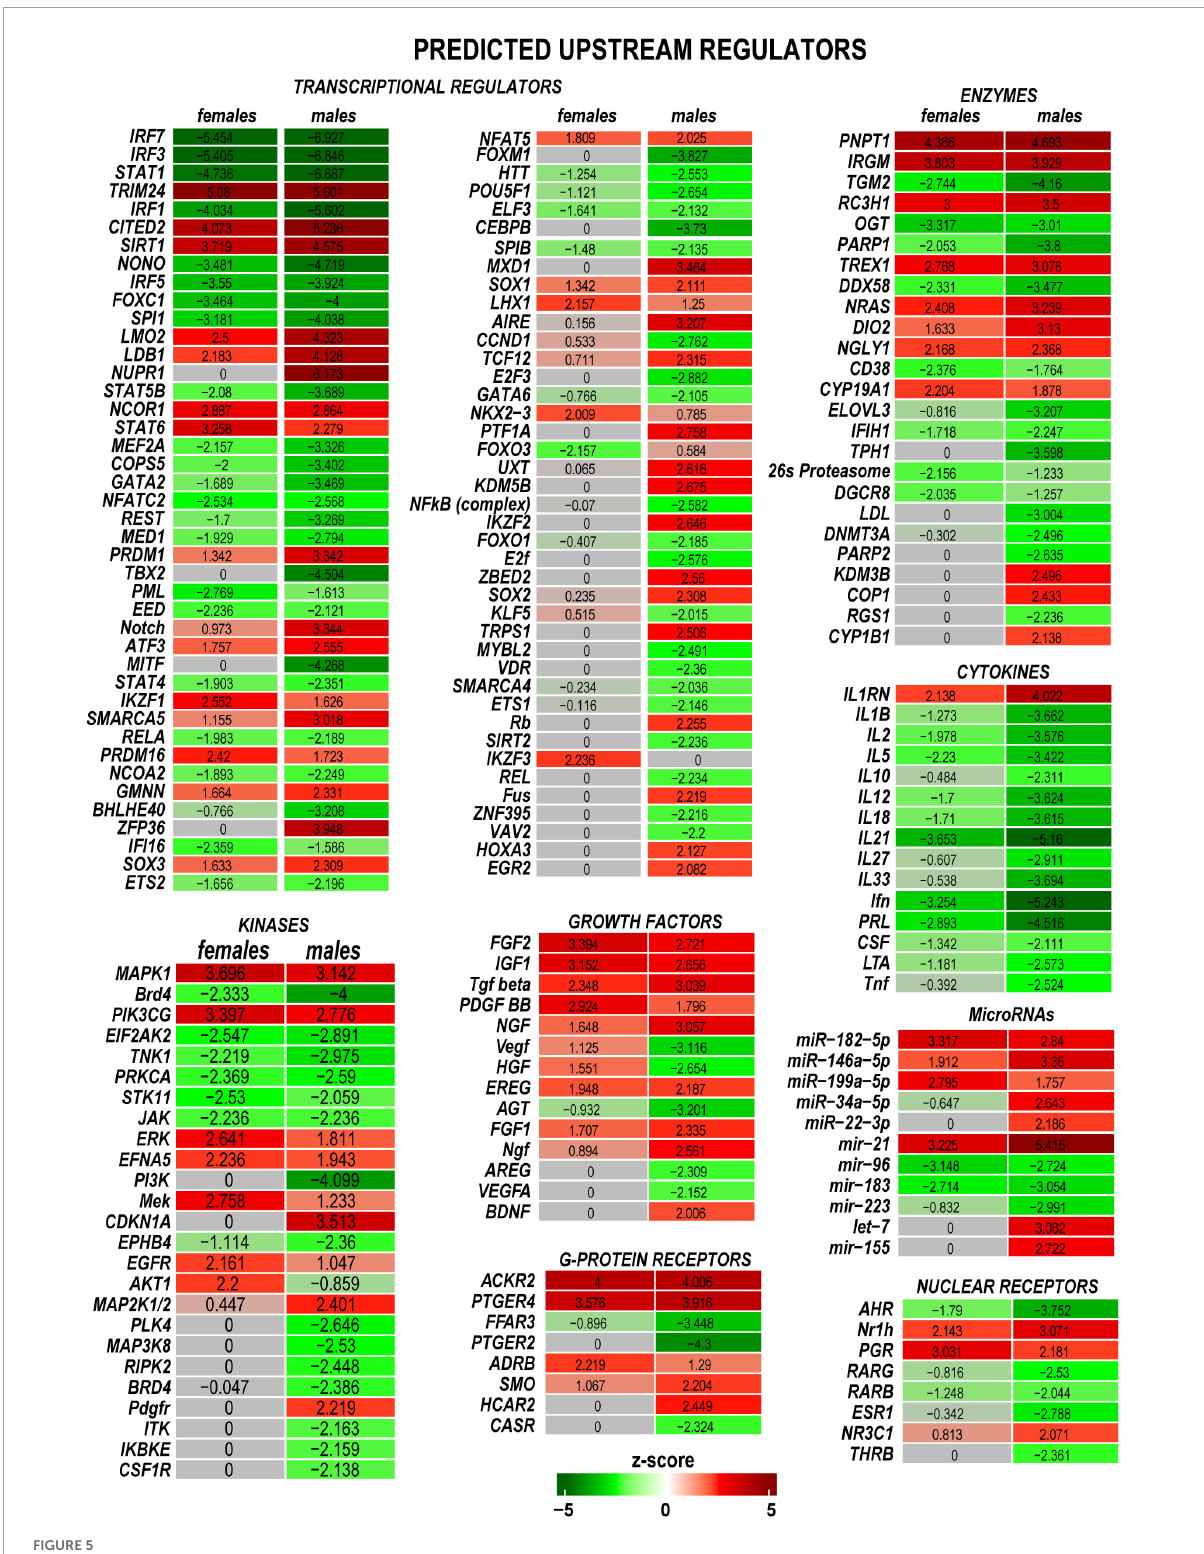
FIGURE5 Upstream regulators of the post-injury response included transcriptional regulators, kinases, growth factors, G-protein receptors, enzymes, cytokines, microRNAs, and nuclear receptors. Positive (red) and negative (green) z-scores indicate regulator effects to upregulate or downregulate respective differentially expressed genes (DEGs). The color scale represents the z-score